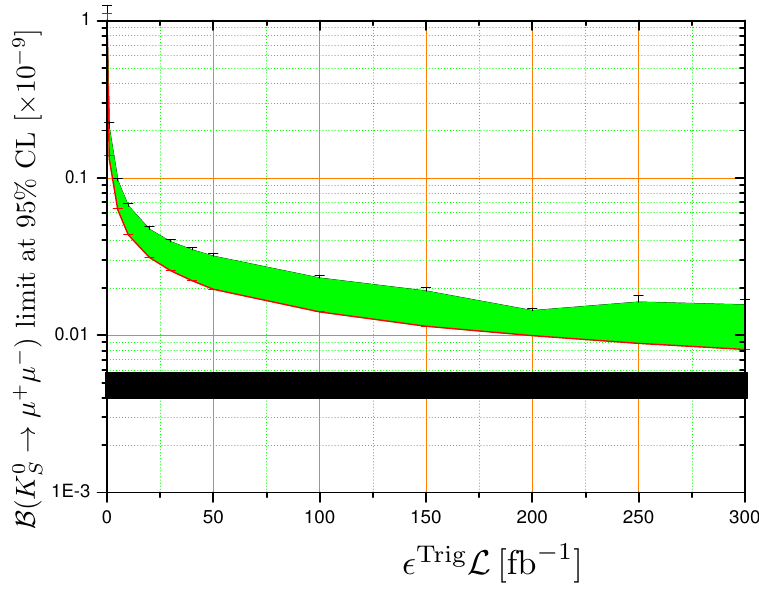
Figure 4 . Expected upper limit of product of the integrated luminosity and trigger e(cid:14)ciency, taken from ref. [34]. The LHCb upgrade is expected to collect 50fb (cid:0) 1 , and the Phase-II